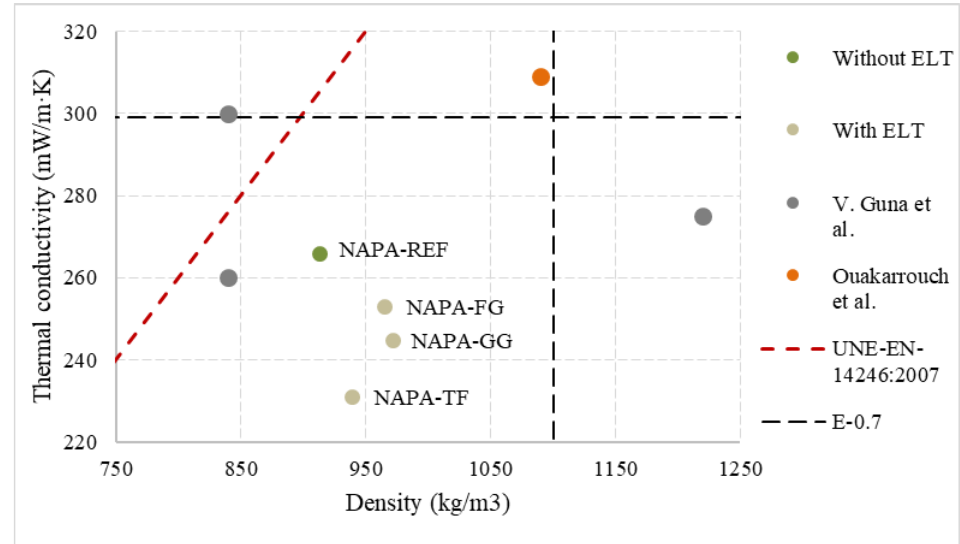
Figure 19. Dispersion comparative thermal conductivity results.